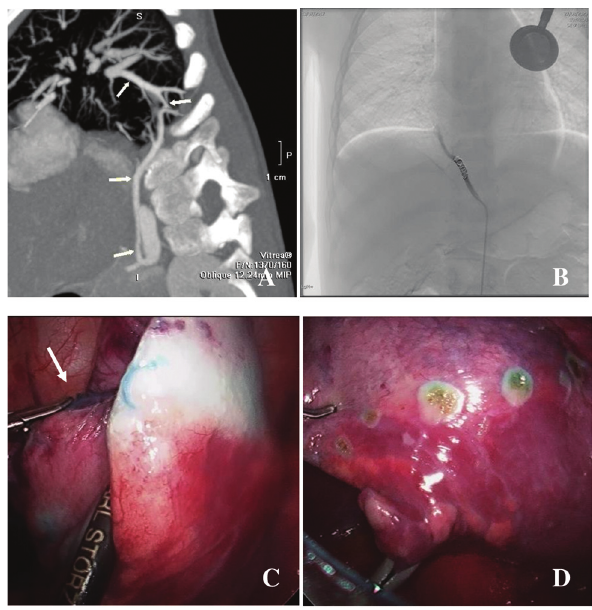
Fig. 1 3-year-old patient. ( A ) Preoperative chest CT with contrast; white arrows (below): aberrant feeding artery coming from abdomi- nal aorta, white arrows (up): venous return. ( B ) “ Sub ” -embolization with coil, correct timing for methylene blue injection into the aberrant artery. ( C ) Thoracoscopic view; white arrow: endoscopic injection needle placed in the embolized artery. ( D ) After electrocoagulation marking of the sequestration and before resection. CT, computed tomography.